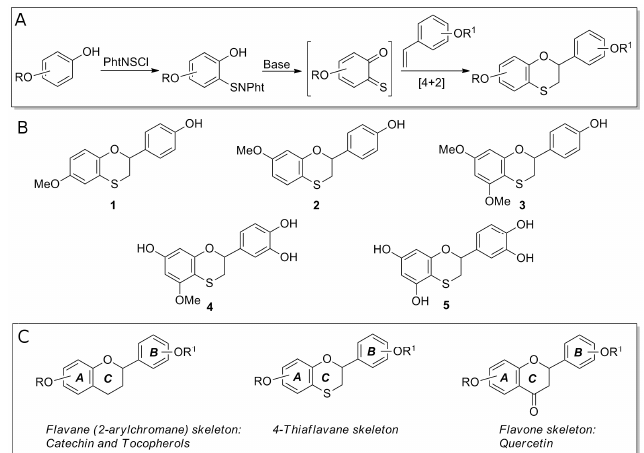
Figure 1. Design of hydroxylated 4 ‐ thiaflavanes and their biomimetisms. ( A ) Synthesis of hydroxylated 4 ‐ thiaflavanes used in this study. ( B ) Structure of 4 ‐ thiaflavanes tested in this study. ( C ) Biomimetism of 4 ‐ thiaflavanes with 2 ‐ arylchromane (flavane) and flavone skeletons.